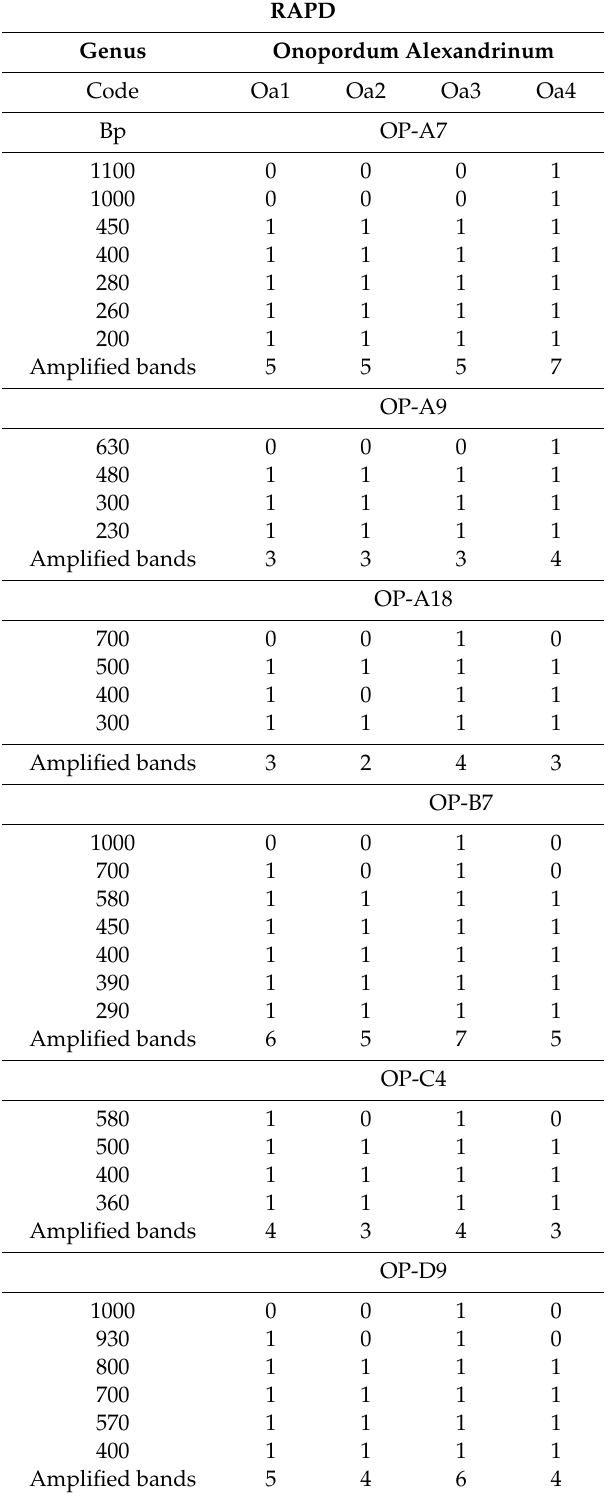
Table 2. Profiles of RAPD and ISSR primers used for the study genetic diversity of di ff erent habitats of Onopordum alexandrinum . 1 = Oa1 (sand dunes), 2 = Oa2 (abandoned fields), 3 = Oa3 (barley fields), 4 = Oa4 (desert